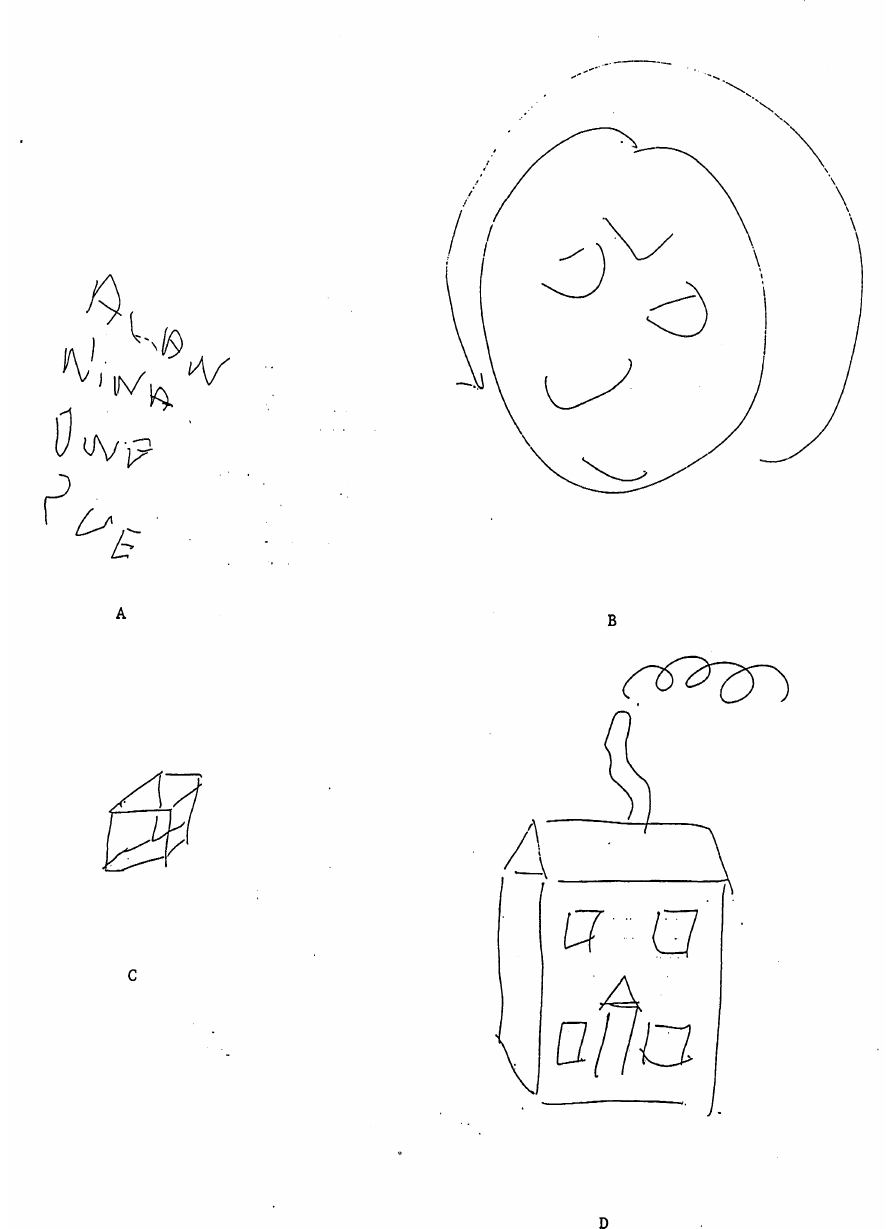
FIG. 3, MP's left handed writing and attempt to draw a face at 14 month follow up (A and B). Right handed drawing of cube and house at follow up (C and